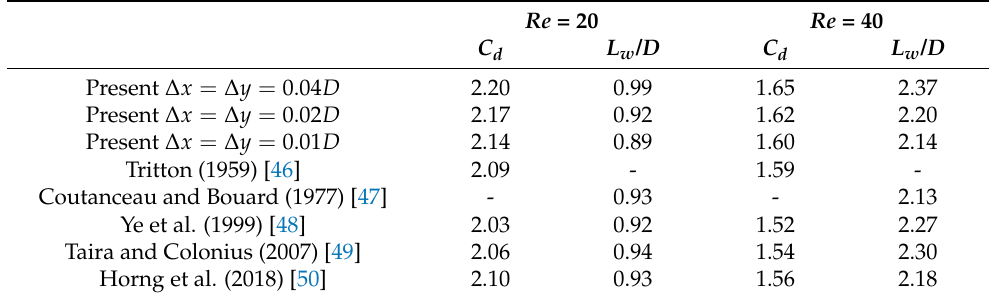
Table 1. Comparison of the drag coefficient and the length of steady state wake for Re = 20 and Re = 40.